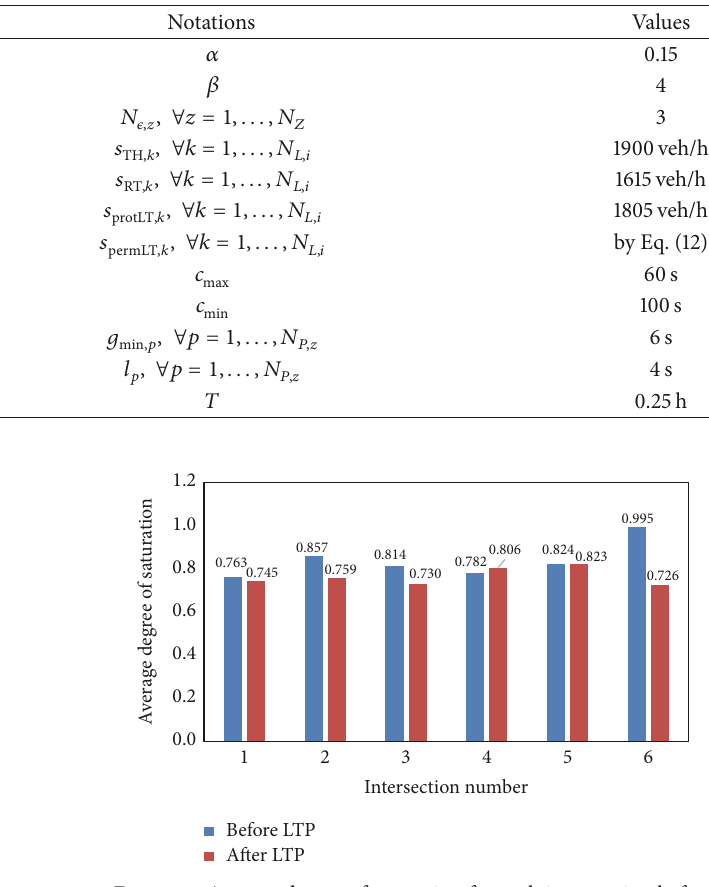
Table 2: Values of parameters.